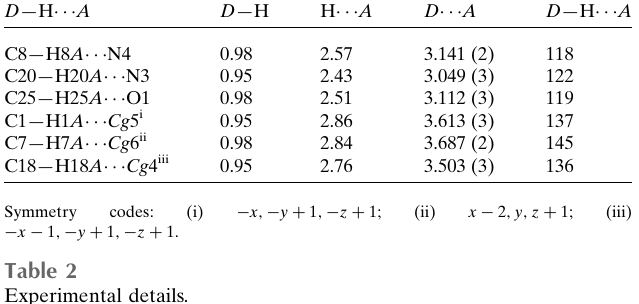
Figure 1 A view of the molecular structure of the title compound, with the atom labelling. Displacement ellipsoids are drawn at the 50% probability